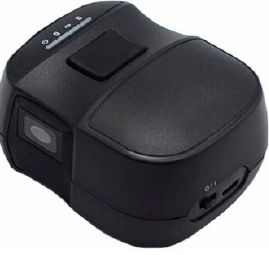
Figure 1. ‘NIR-S-G1 (cid:48) miniature spectrum acquisition Figure 1. ‘NIR-S-G1’ miniature spectrum acquisition instrument .